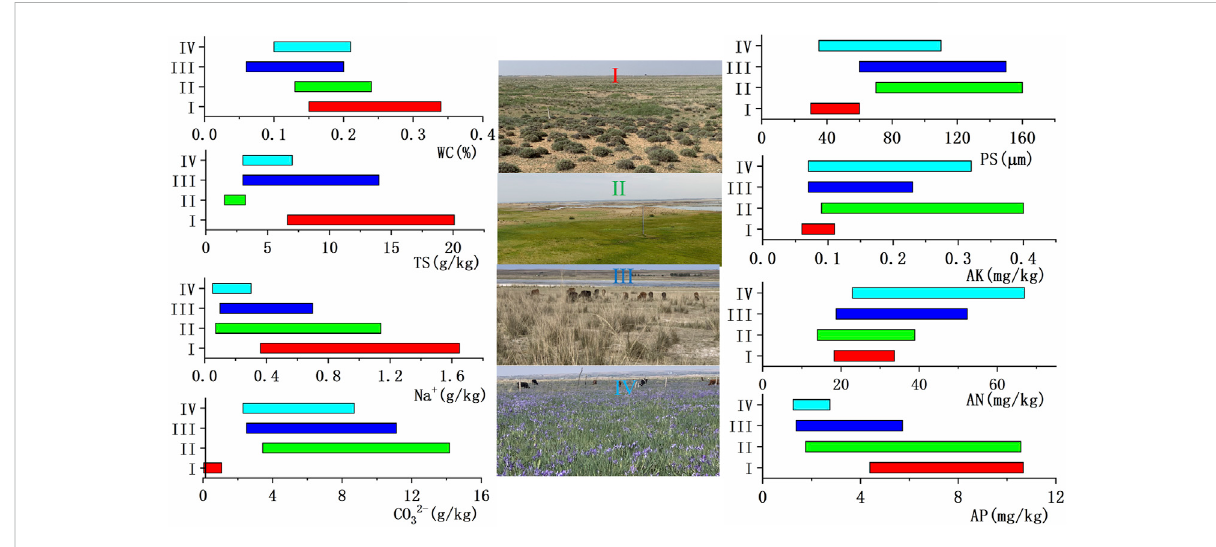
FIGURE 9 Intervals and values of ecological response